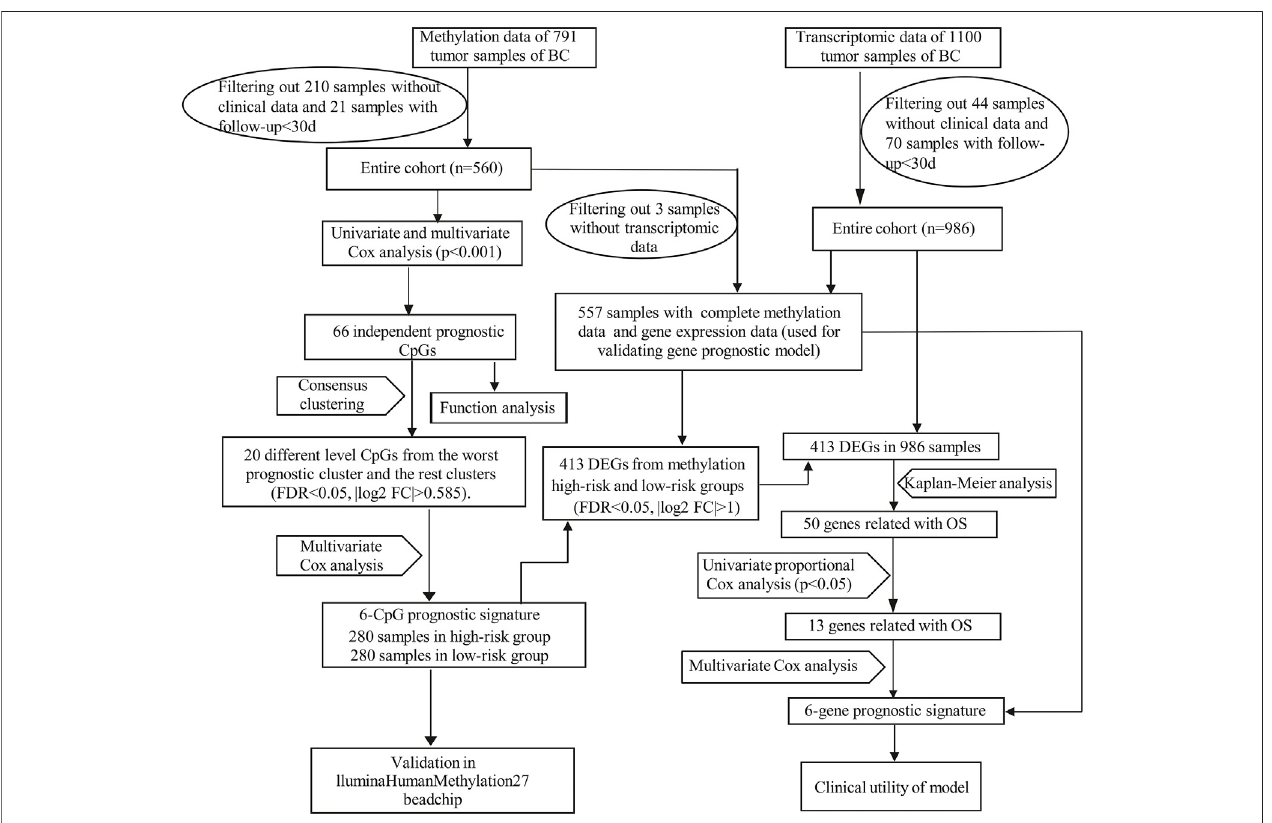
FIGURE 1 | The work fl ow for this study. DEGs, differentially expressed genes.